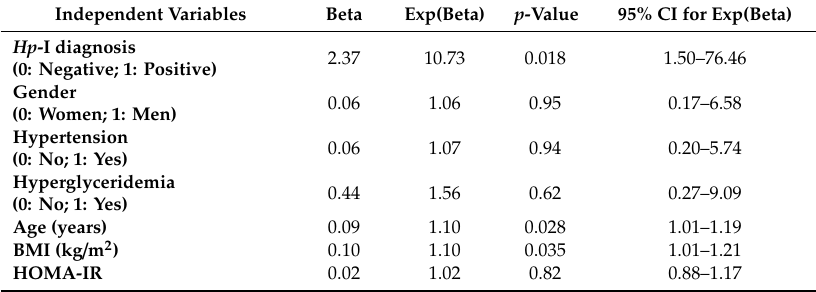
Table 3. Independent associates of severe NASH (No vs. Yes), according to FLIP classification in binary logistic regression